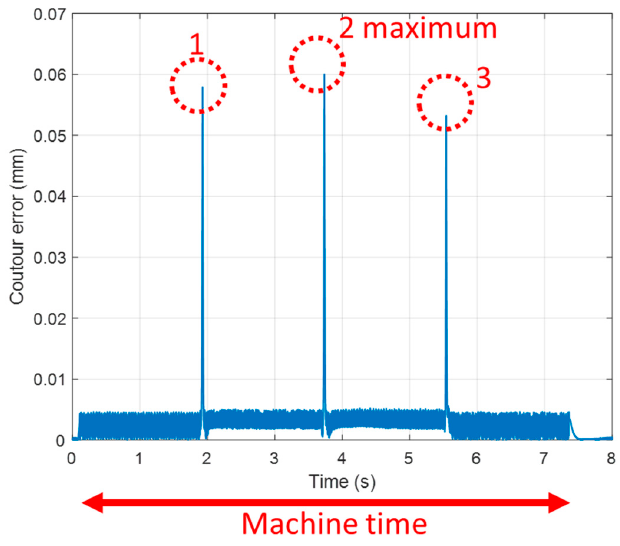
Figure 8. Maximum contour error (MCoE) and machining time (MT) for one experiment. (The period 1, 2 and 3 were marked as the corner 1, 2 and 3 in Figure 7, respectively.)